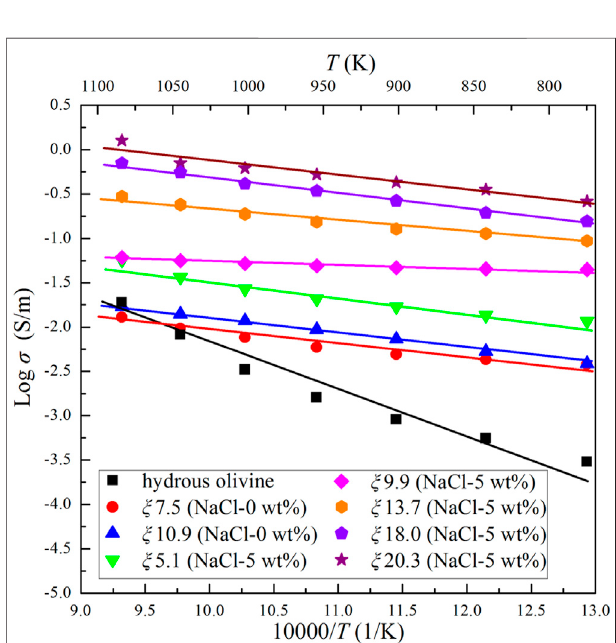
FIGURE 4 | Electrical conductivities of hydrous olivine aggregates and the Ol – NaCl – H 2 O system with a salinity of 0 – 5 wt% and fl uid fraction of 5.1 – 20.3 vol% at 2.0 GPa and 773 – 1073